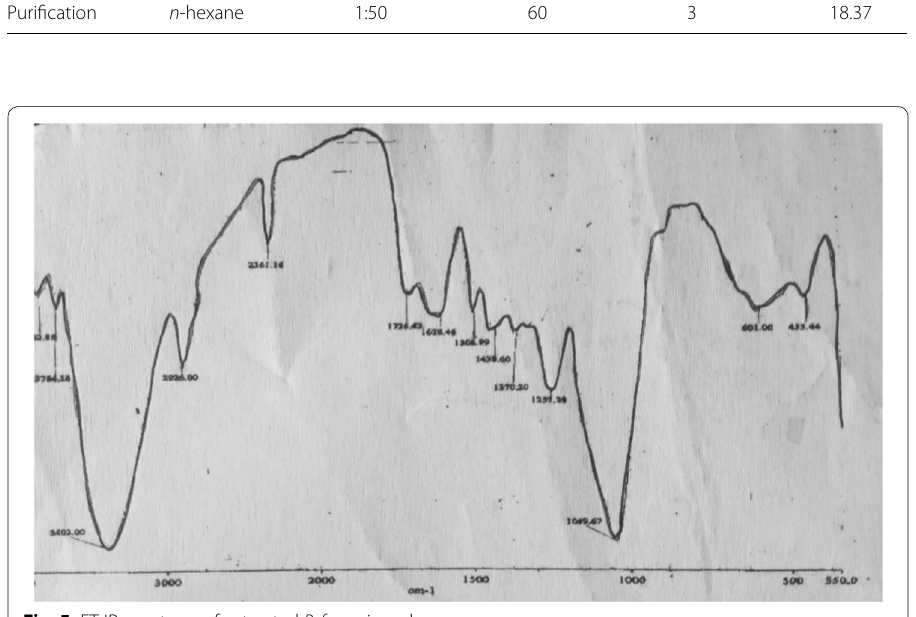
Fig. 5 FT-IR spectrum of extracted B. ferruginea